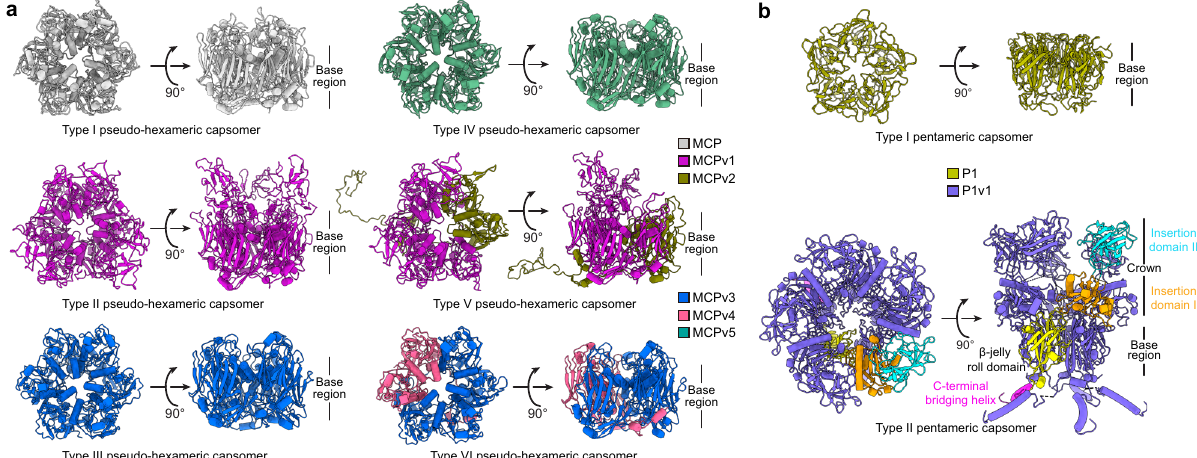
β -jellyrolldomain,insertiondomainIandinsertiondomainIIofoneP1v1molecule in the typeIIpentamericcapsomer arecolored magenta, yellow, orange, and cyan, respectively.